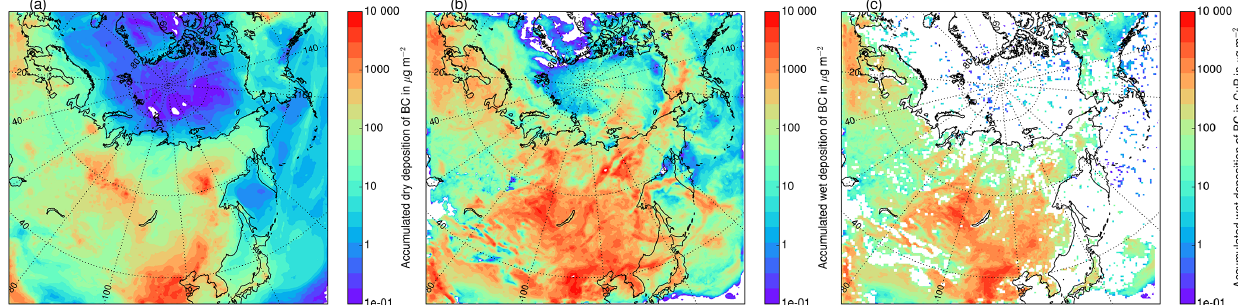
Figure 12. Accumulated deposition of BC due the (a) dry deposition, (b) wet removal in all clouds (grid-resolved and cumuli) and (c) wet removal in parameterized cumulus clouds between 7 and 21 July. Note the logarithmic color